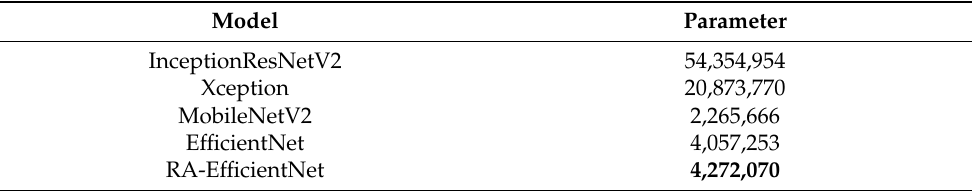
Table 4. Comparison of parameters for different CNN networks for Task